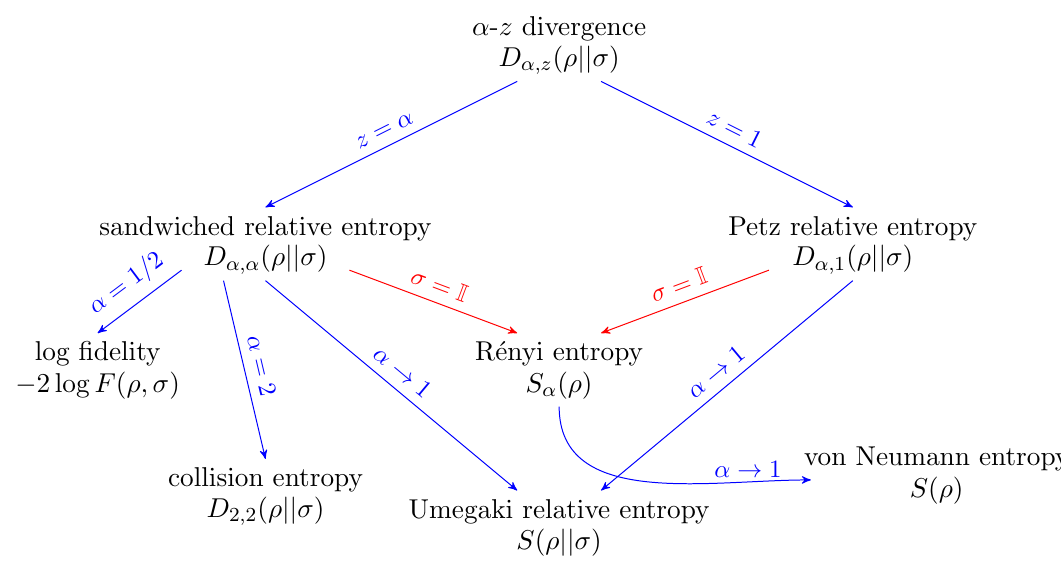
Figure 1. Some members of the entropy zoo and their relations. The α - z divergences contain as special cases many common quantities appearing in quantum information theory. This figure is a simplified version of one produced by Faist [1]. Blue arrows indicate a choice of the parameters α, z has been made, red arrows that the reference state has been set to the identity